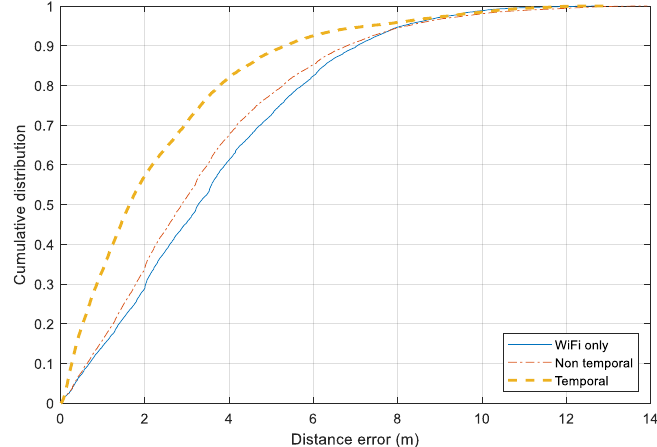
Figure 13. Cumulative distance error distribution for three approaches.